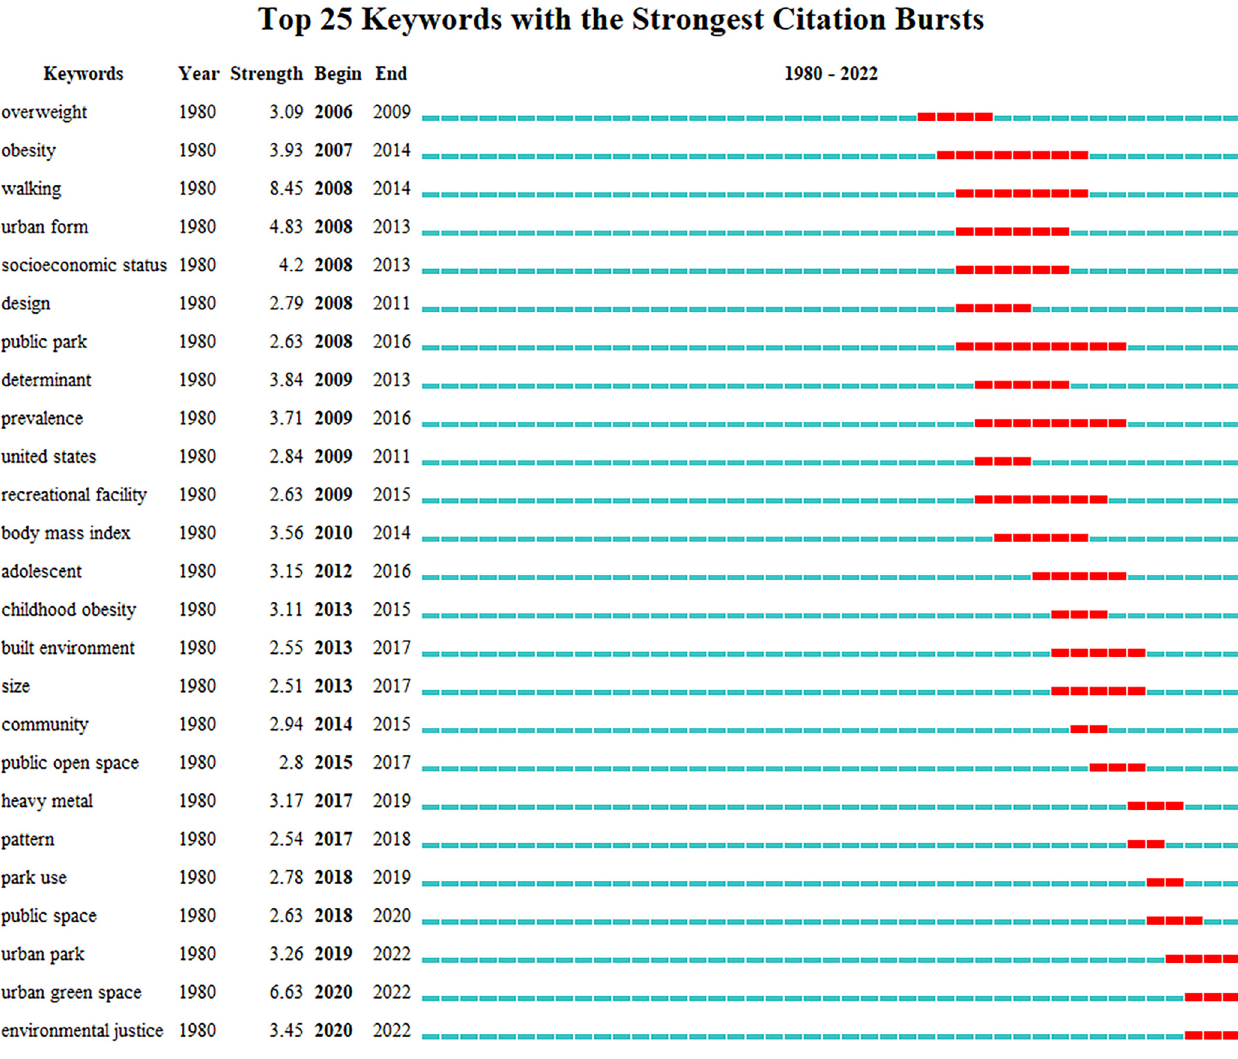
Figure 10. Top 25 keywords with the strongest bursts.